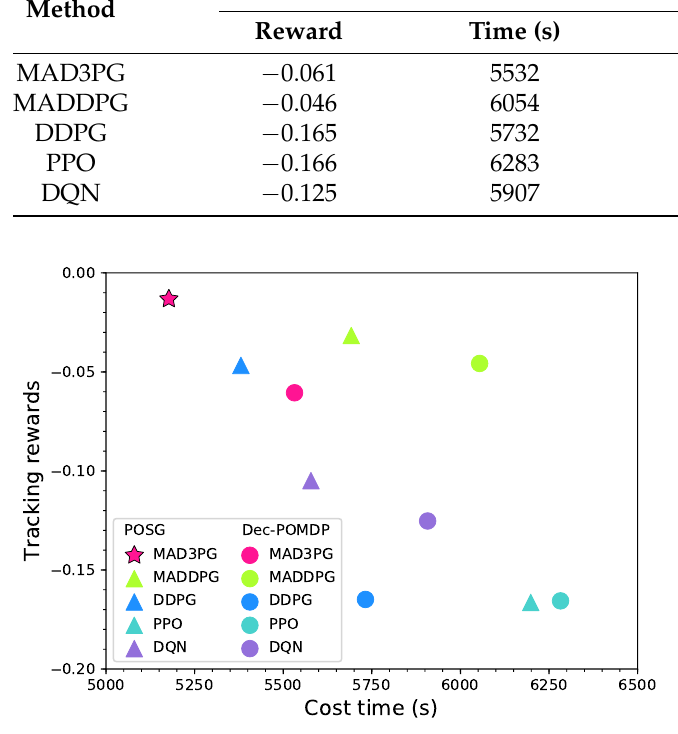
Figure 3. Comparisons of the tracking rewards and the time